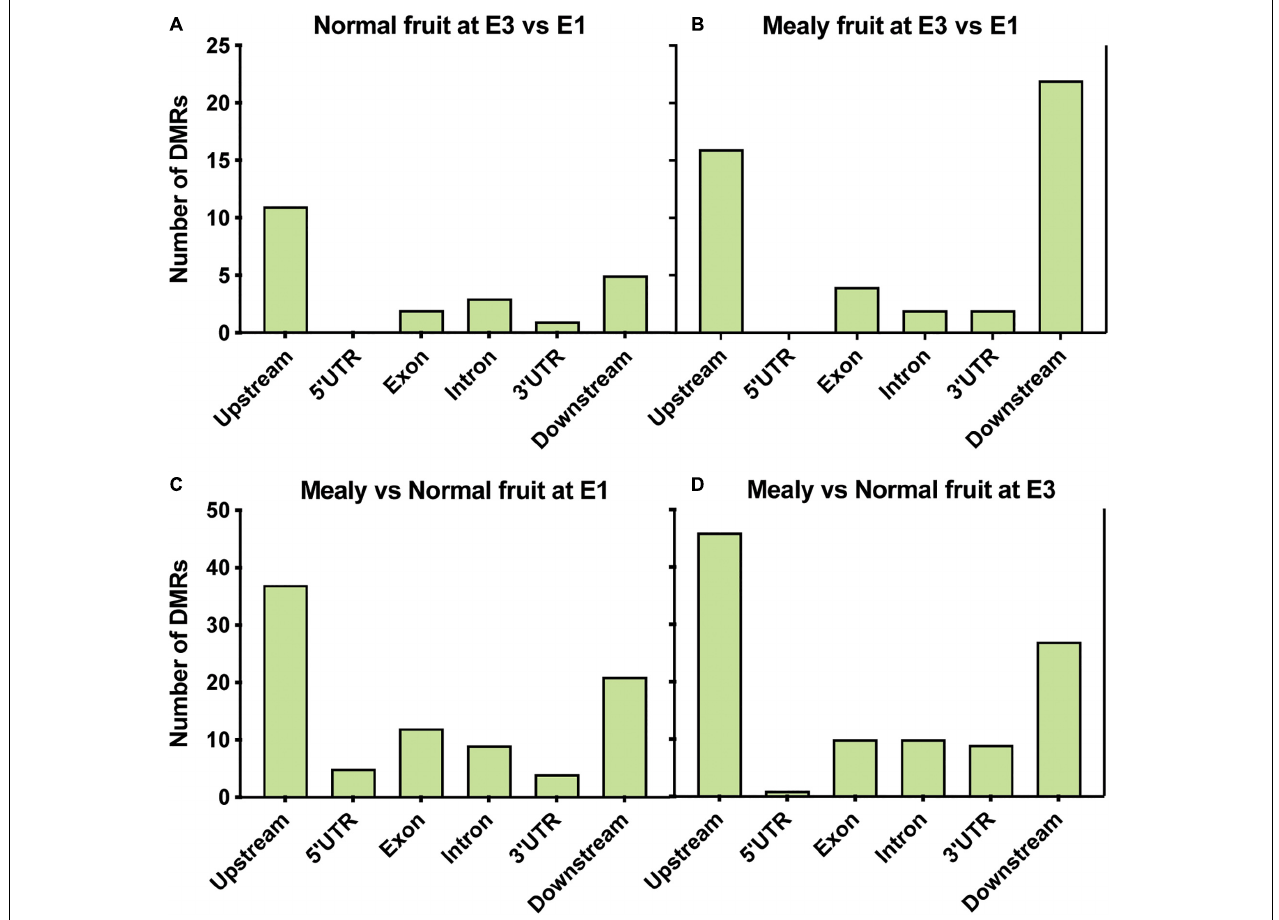
FIGURE 4 | Location of DMRs within annotated genes of P. persica . Number of DMRs located upstream (up to 2 kb), 5’ UTR, exons, introns, 3 (cid:48) UTR, and downstream (up to 2 kb) of annotated genes in samples from (A) normal fruits at E3 vs. E1 (B) mealy fruits at E3 vs. E1 (C) mealy vs. normal fruits at E1, and (D) mealy vs. normal fruits at